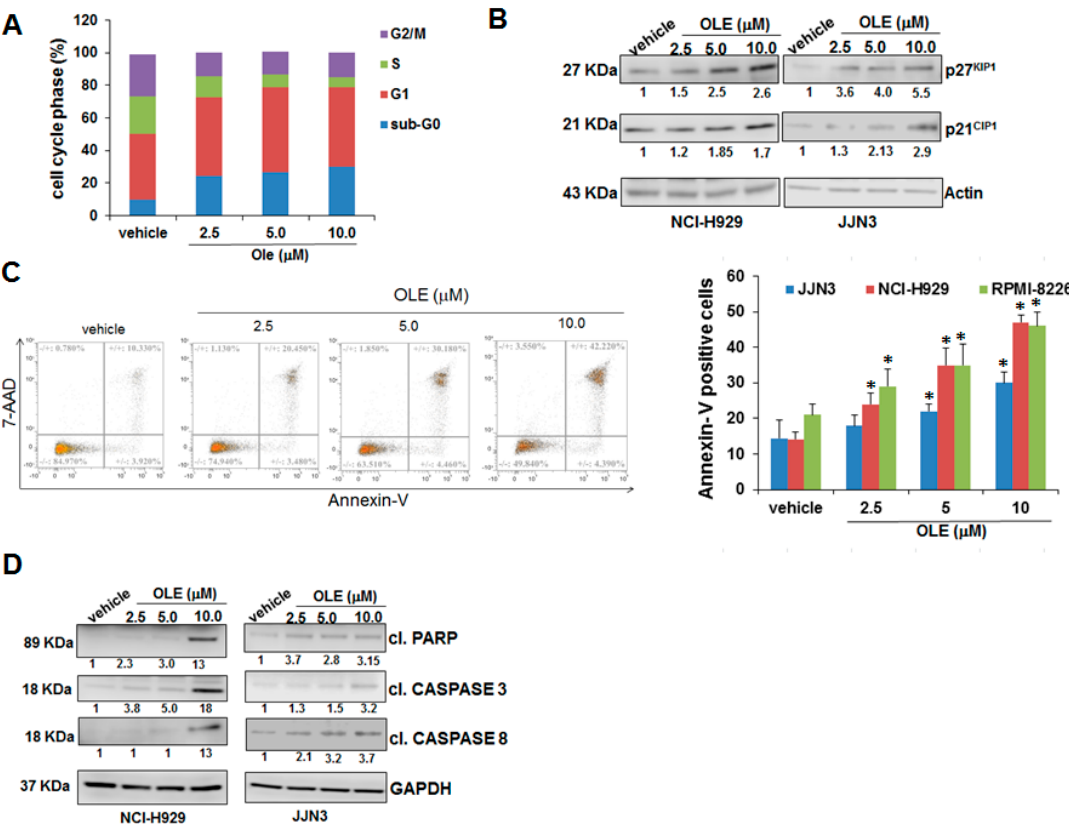
Figure 2. Oleacein triggers cell cycle blockade and apoptosis. ( A ) Cell cycle analysis was performed on NCI-H929 cells by PI staining, 24 h after treatment with oleacein or vehicle (DMSO). ( B )Western Blot (WB) analysis of p27 KIP1 and p21 CIP1 in whole cell lysates from MM cells after treatment with oleacein for 24 h; actin was used as loading control. ( C ) Annexin V / 7-AAD staining of MM cells after treatment with oleacein for 48 h; a representative experiment on NCI-H929 cells is shown on the left side. ( D ) WB of PARP1, cleaved caspase-3 and cleaved caspase-8 in NCI-H929 and JJN3 cell lines after 24 h of oleacein treatment; GAPDH was used as loading control. * p < 0.05 as compared to vehicle-treated cells.